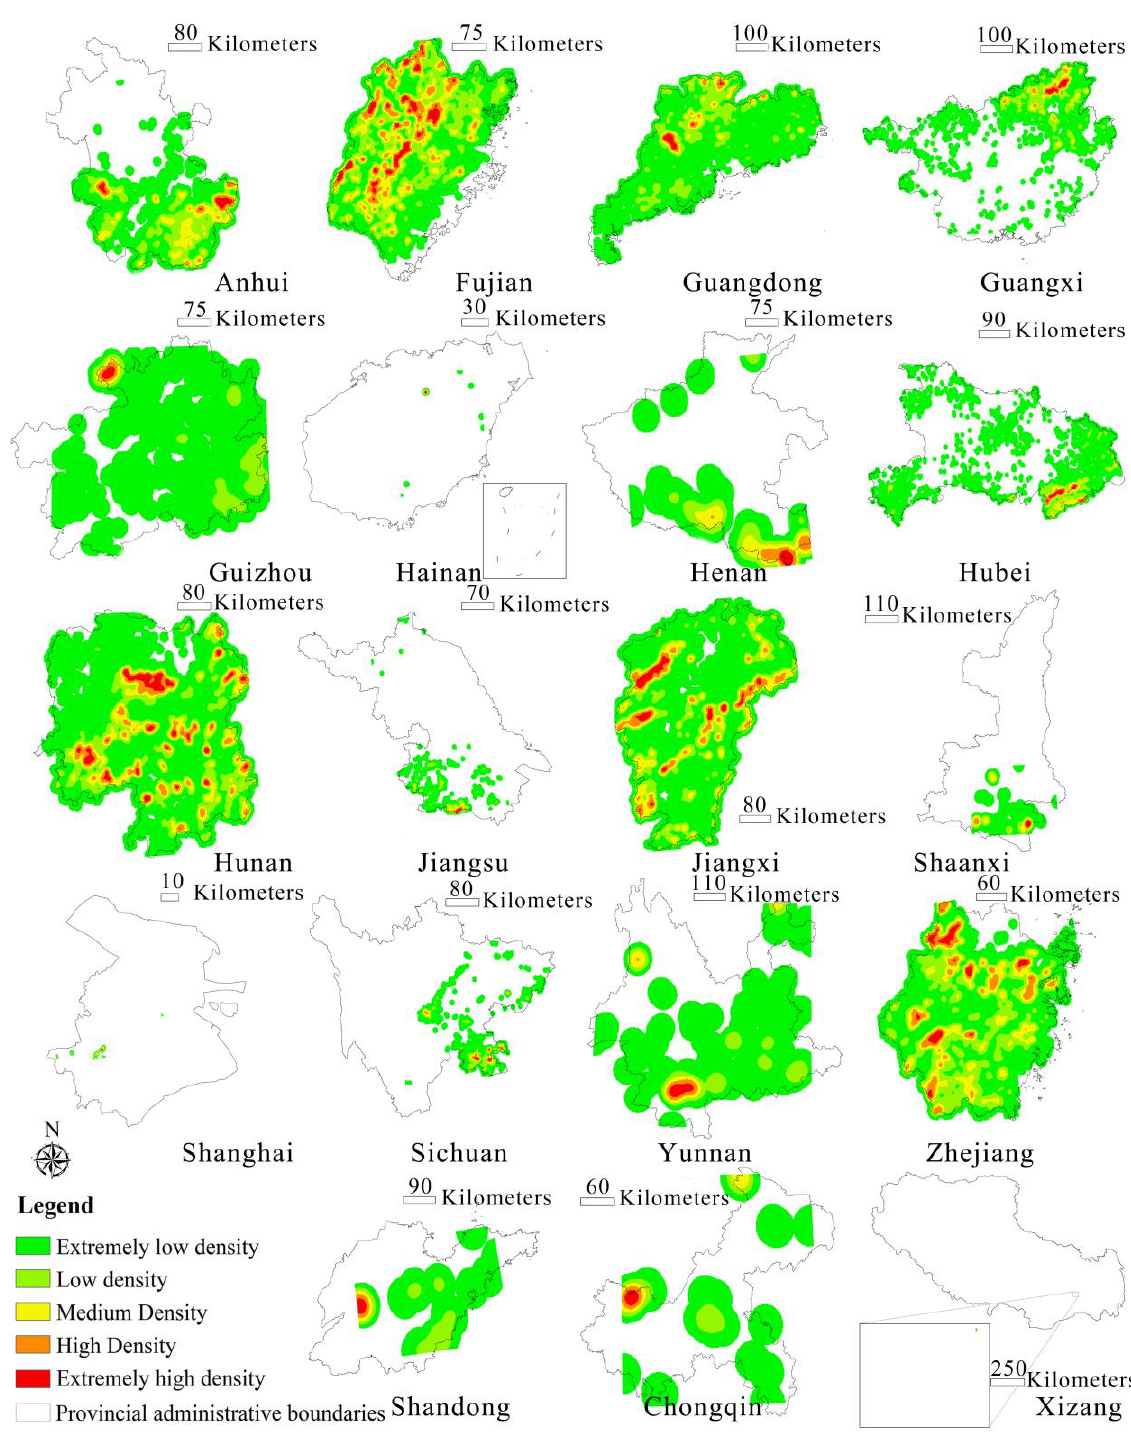
Figure 5. Spatial aggregations of moso bamboo forests by the province in 2020.